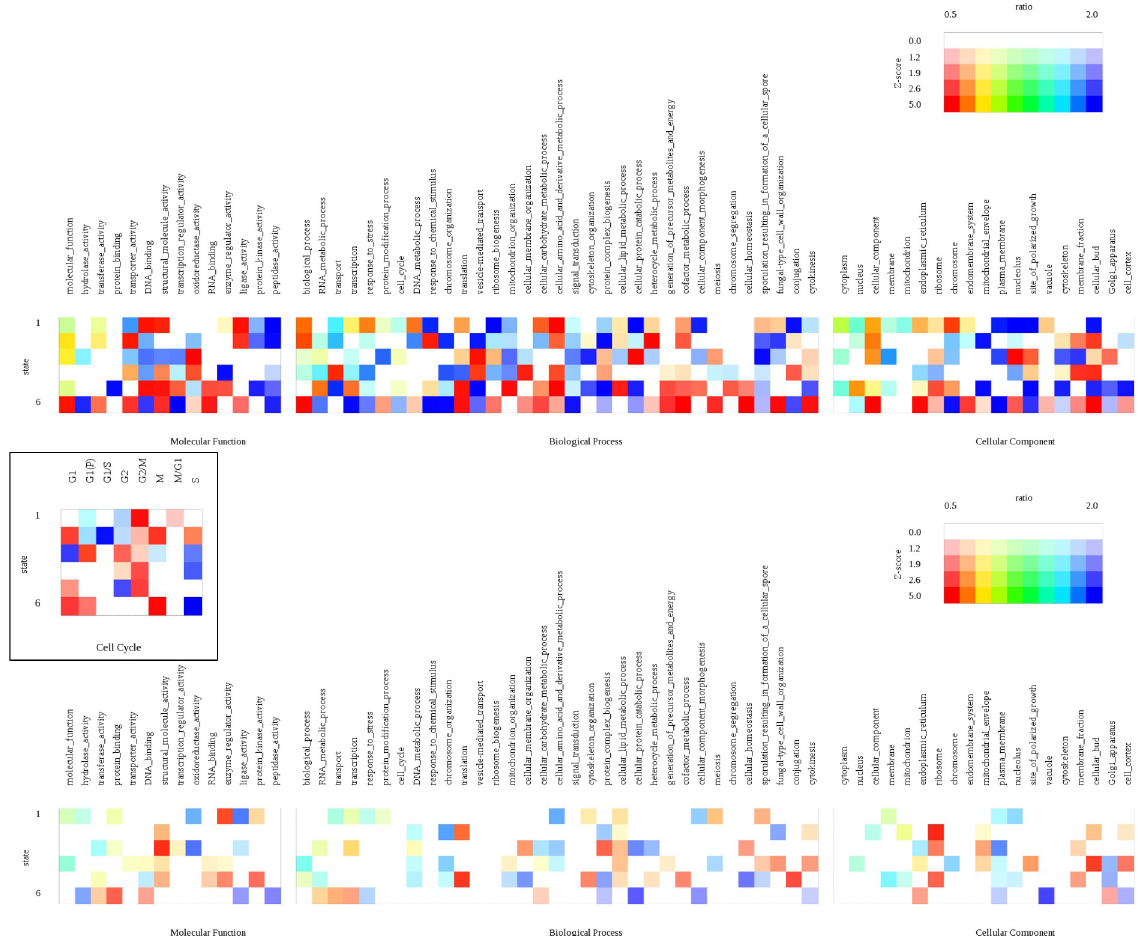
Fig 4. Analysis of functional annotation (significant GO terms) of genes whose loci interact in each of 5 inferred conformational states of the genome (top), compared to similar analysis for locus pairs with randomly assigned states (bottom). Inset: enrichments of genes associated with specific phases of the cell